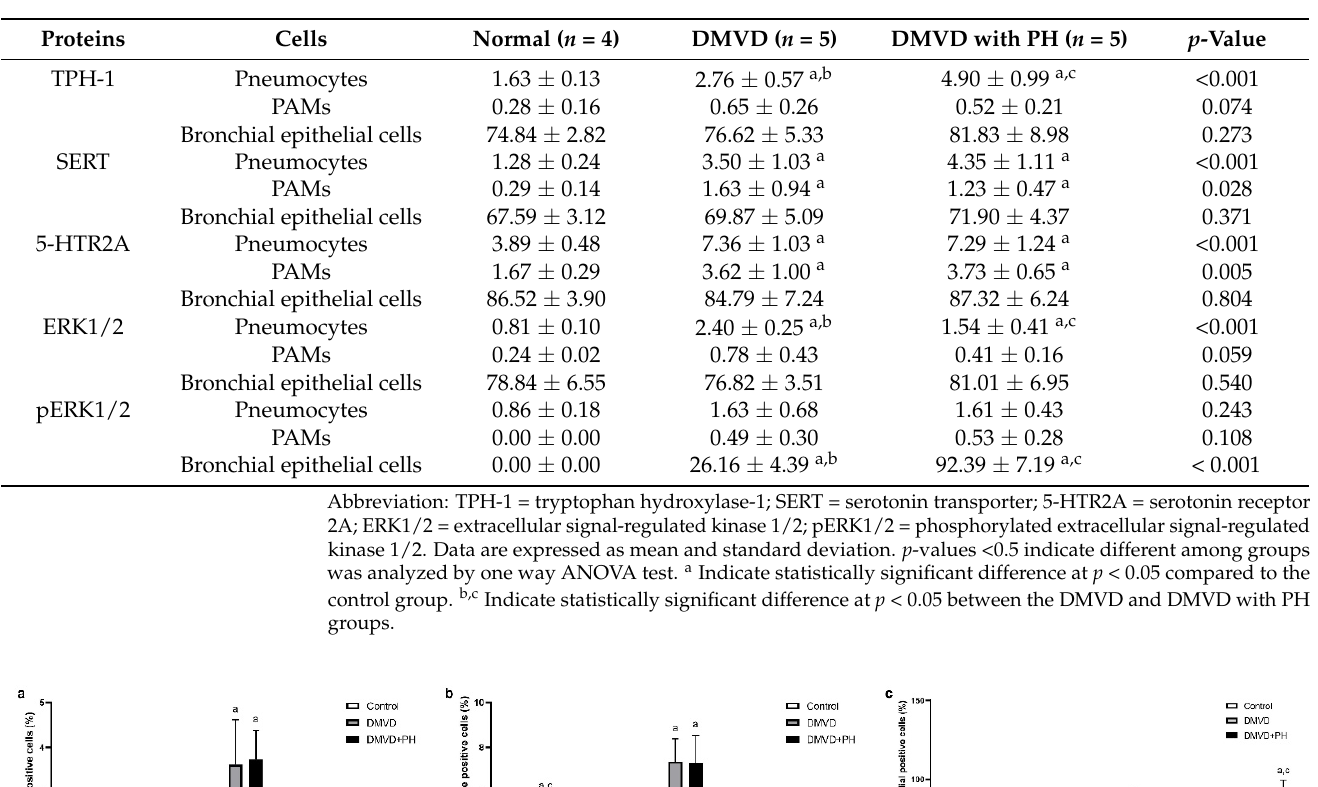
Table 6. The average percentage of TPH-1, SERT, 5-HTR2A, ERK1/2 and pERK1/2 positive pneumo- cytes, PAMs and bronchial epithelial cells in the control, degenerative mitral valve disease (DMVD) and degenerative mitral valve disease with pulmonary hypertension (DMVD with PH) groups.